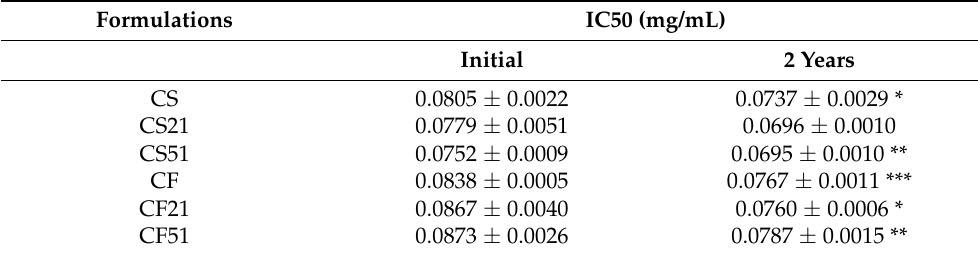
Table 9. DPPH assay obtained IC50 values.